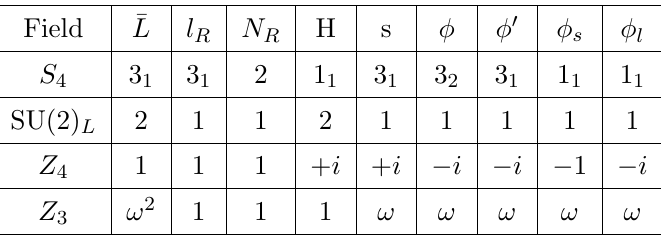
Table 1 . Fields and their respective transformations under the symmetry group of the